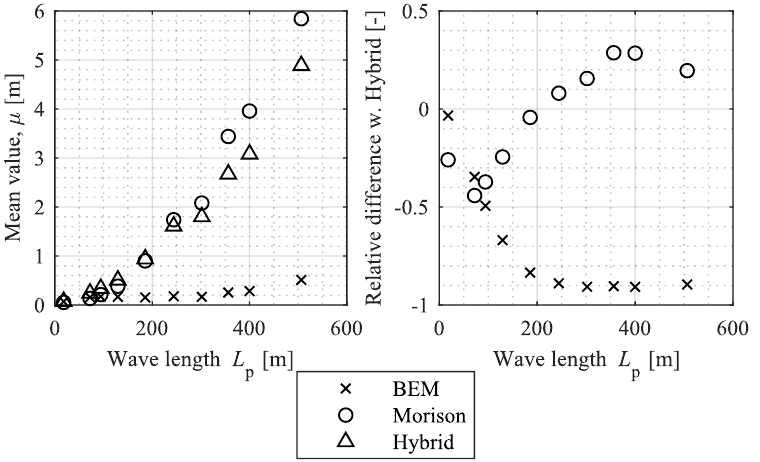
Figure 4. Mean value, µ , of the surge displacement, corresponding to the mean wave drift ( left ). The right figure illustrates the relative difference with the hybrid